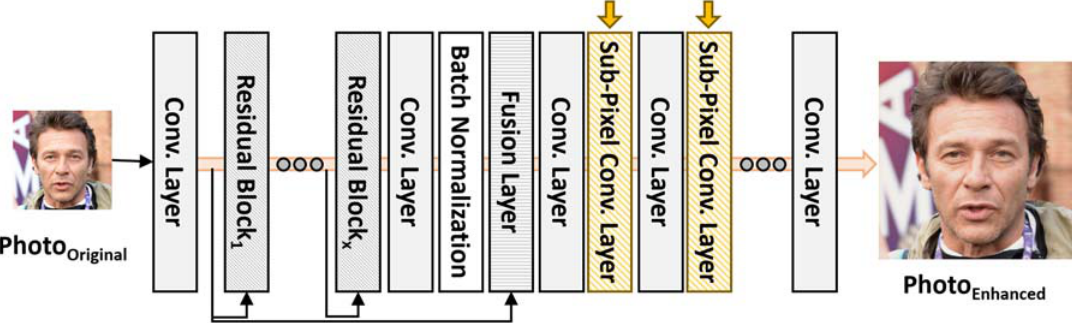
Figure 7. Generator in SR ‐ GAN with Sub ‐ Pixel convolution layers.